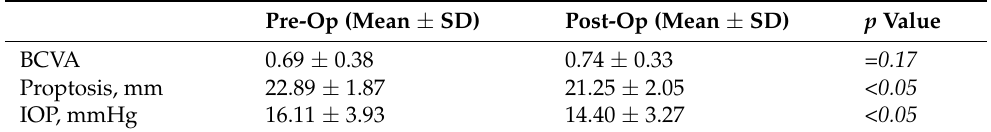
Table 2. Comparisons of preoperative and postoperative (3 months after TEOD) data of BCVA, proptosis and IOP.